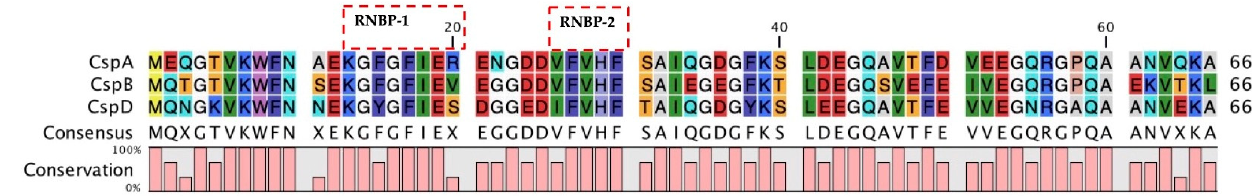
Figure 1. Csp protein sequences based on L. monocytogenes EGDe genome, highlighted under the red rectangles, are the two RNA-binding motifs (RNBP). Figure created using QIAGEN CLC Genomics Workbench 20.0 (available online: https://digitalinsights.qiagen.com/ (accessed on 9 April